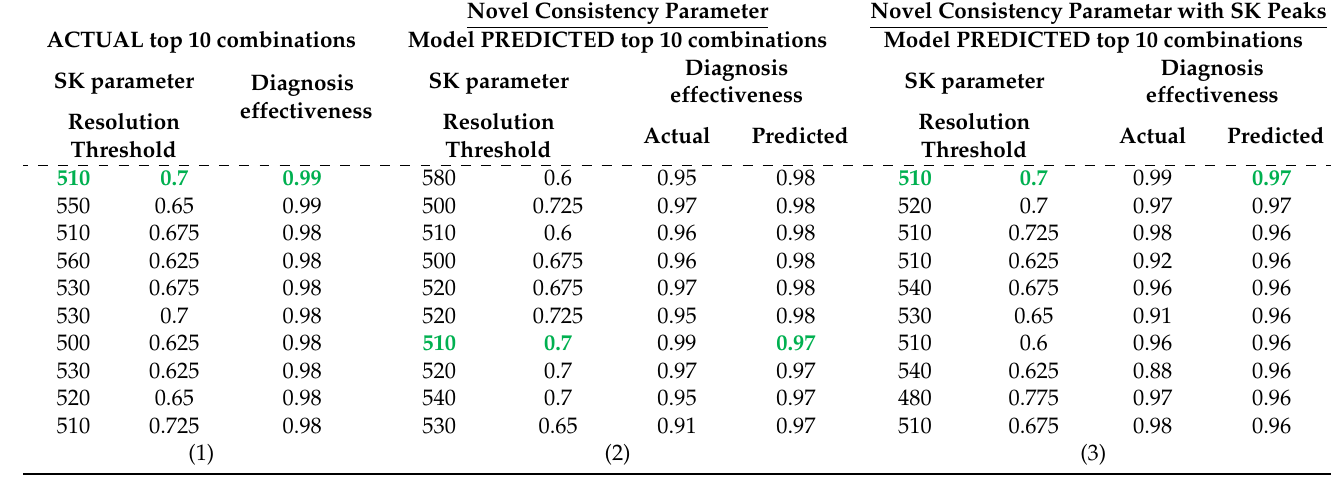
Table 3. Results for the top 10 combinations either ( 1 ) actual, ( 2 ) predicted using novel consistency vectors, or ( 3 ) predicted using novel consistency vectors with SK peak information. Both novel methods have used 3 consistent SK peaks data as input to the machine learning as this performed universally well in the sensitivity analysis. The rows highlighted in green indicate the actual best performing combination of SK technology parameters for the data and how they are predicted with the novel